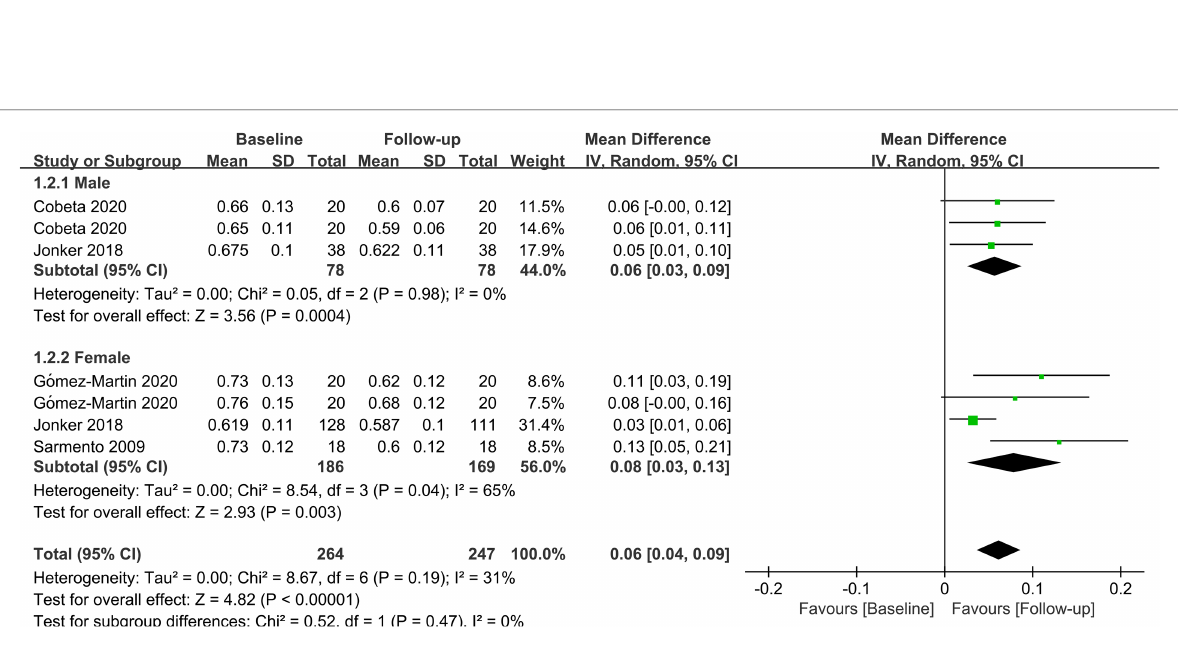
FIGURE 6 Forest plot of meta-analysis for CIMT by gender. (Cobeta 2020 and Gomez-Martin 2020 respectively included two subsets of data for